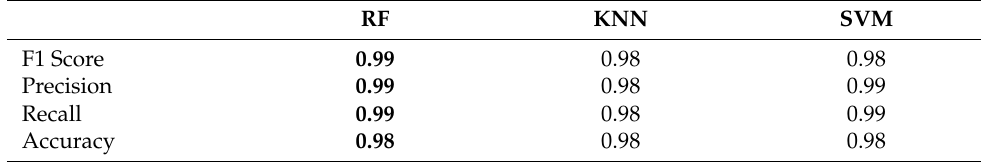
Table 4. Detection Model Results (Imbalanced Data set).